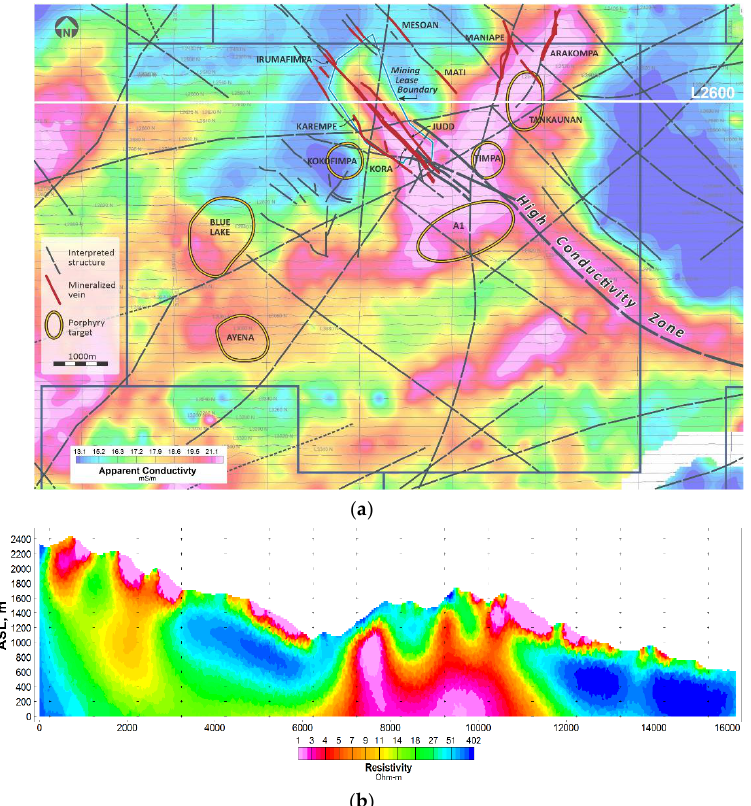
Figure 7. ( a ) MobileMT apparent conductivity color grid (86 Hz) with overlapped mineralized veins, structures, and porphyry targets; ( b ) Resistivity-depth section along 2600 survey line (2D in- version).